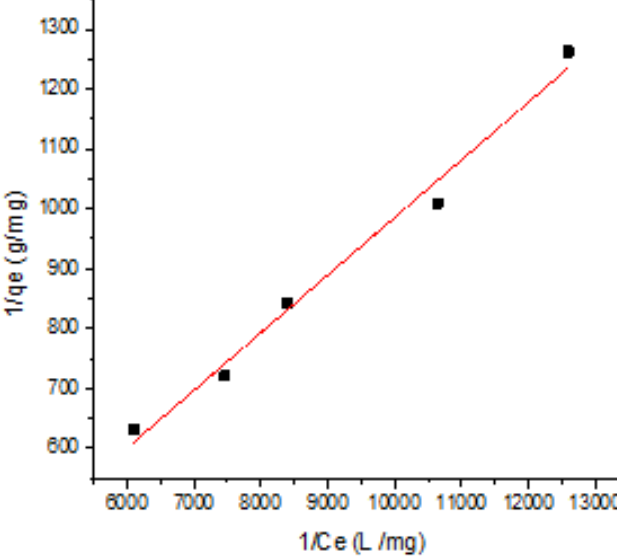
Figure 6. Langmuir adsorption isotherm model of the Basic Red 5 on SMP.